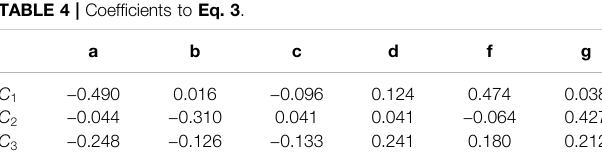
TABLE 4 | Coef fi cients to Eq. 3